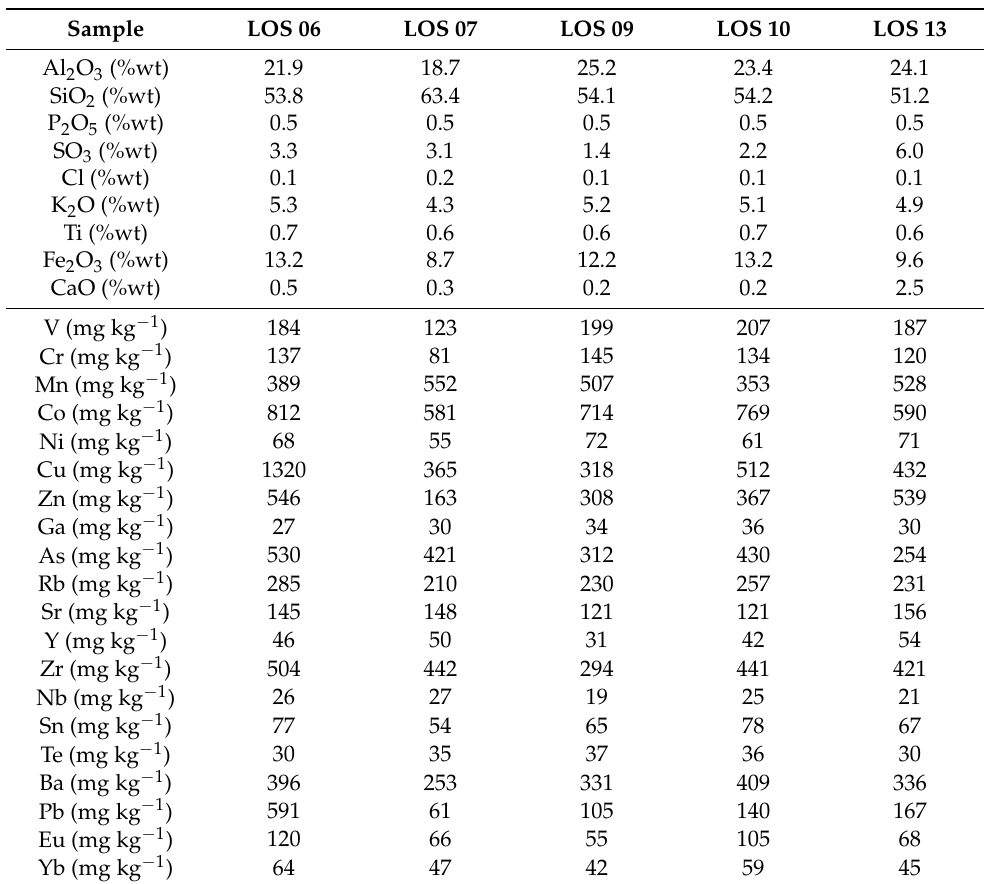
Table 1. Major and trace element concentrations in soil